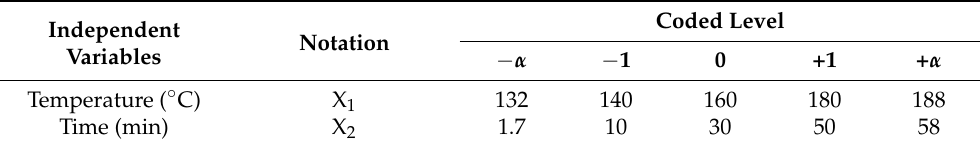
Table 1. Process variables, notation, and their actual values on coded levels. Independent Notation Variables